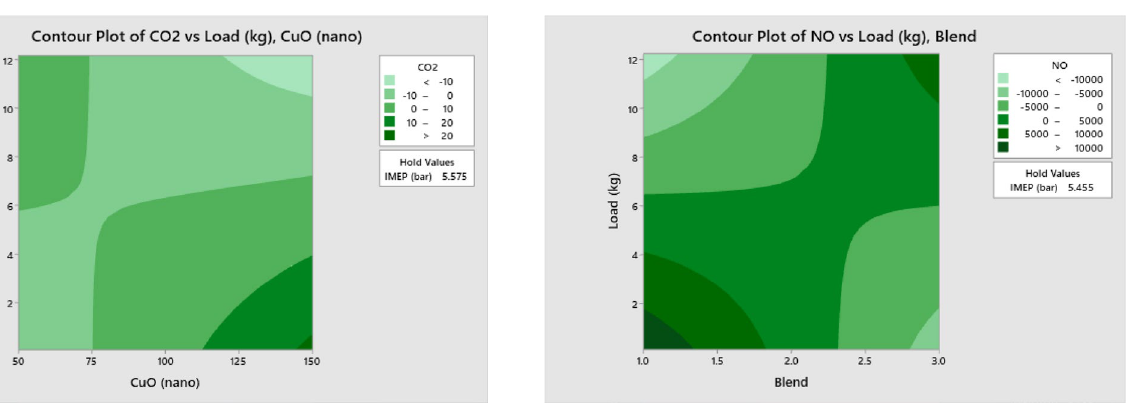
Fig. 32 Contour plot of NOx without nanoparticles